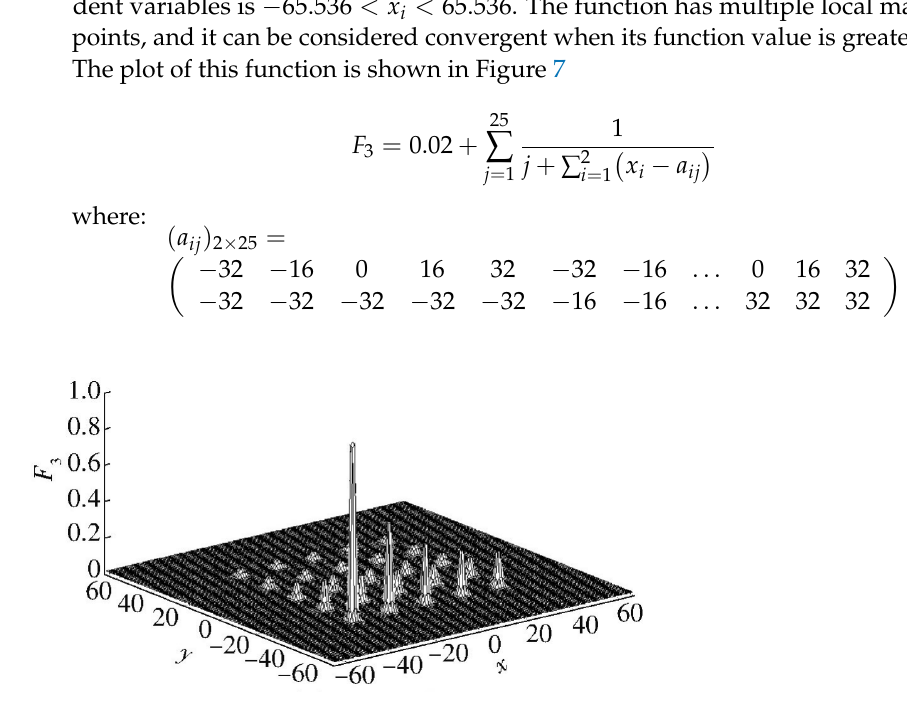
Figure 7. Plot of test function F 3